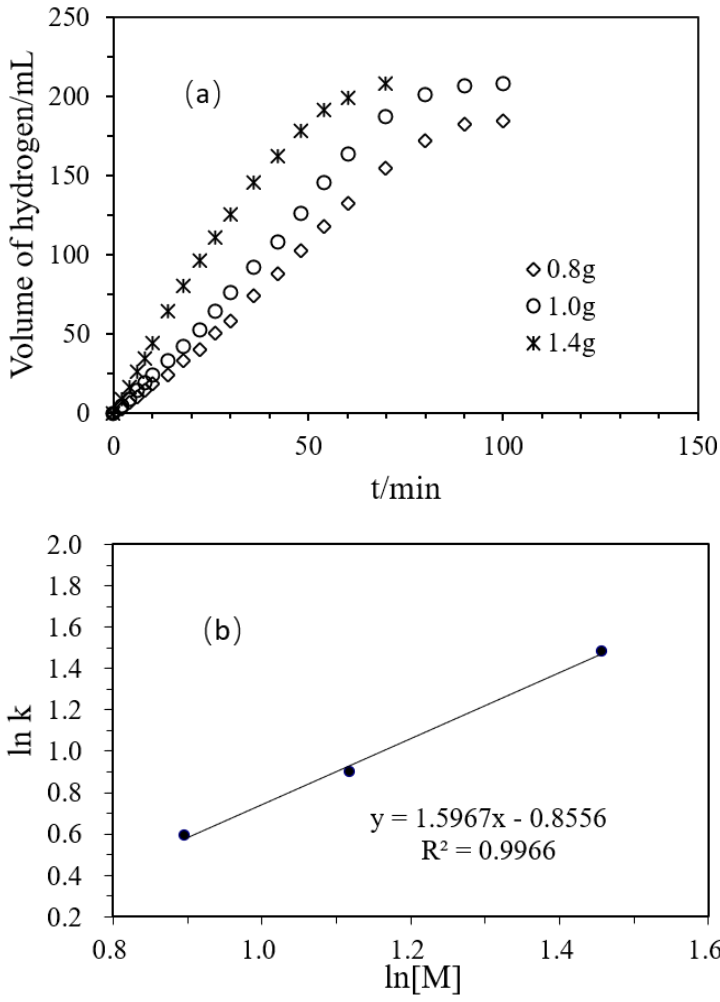
Figure 4. ( a ) Volume of hydrogen versus time plots for the hydrolysis of DMAB catalyzed by Ni/Pd nanoclusters (Ni/Pd = 20/1) with different masses of the hybrid catalyst at 50 °C ; ( b ) Plot of the initial hydrogen production rate (k, in mL min −1 ) versus the total concentration of Pd and Ni (in logarithmic scale, y = 1.5967x − 0.8556). Table 3. Effect of catalysts (Ni/Pd = 20/1) amount for the hydrolysis of DMAB.